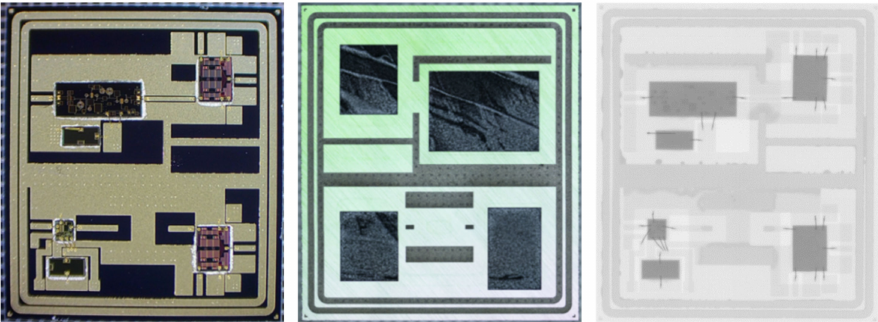
Figure 16. Photos of the diced bottom and cap interposer units and the X-ray of the double stacked module.